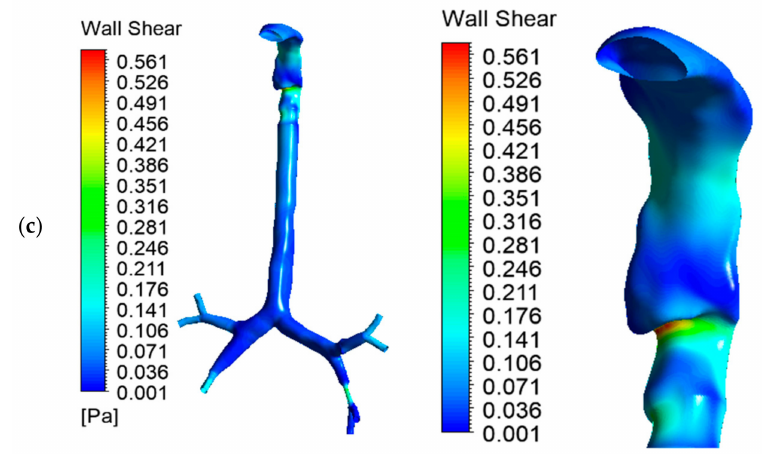
Figure 10. Wall shear for the three lung models at 30 lpm: ( a ) healthy lung, ( b ) left stenosis lung, and ( c ) right stenosis lung. The left panel shows wall shear for the whole model; the right panel shows wall shear at the